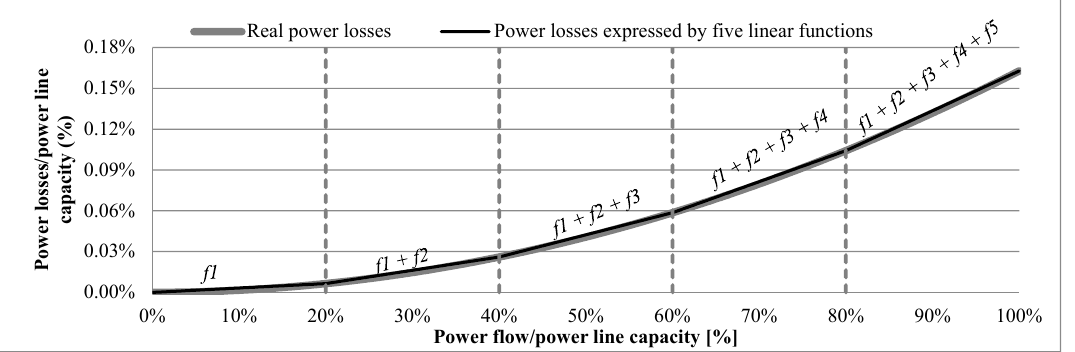
Figure 1. Power losses linearization—spline function consisting of five linear functions.